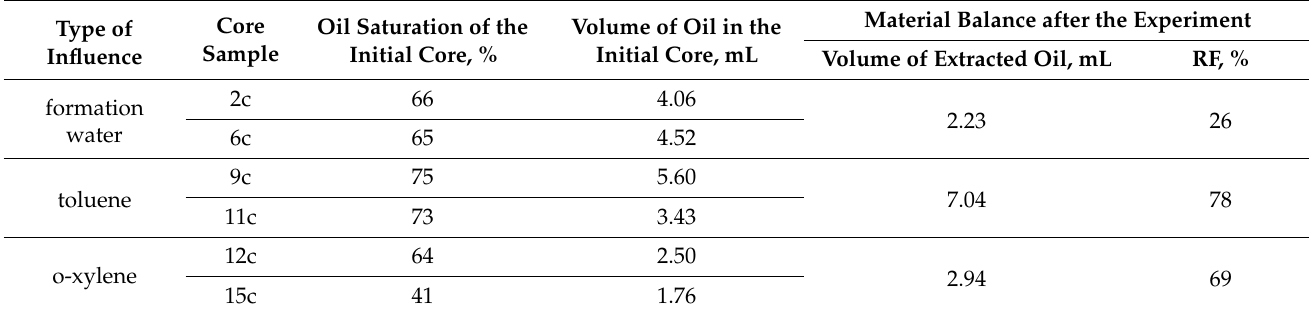
Table 10. Material balance in the filtration experiments.